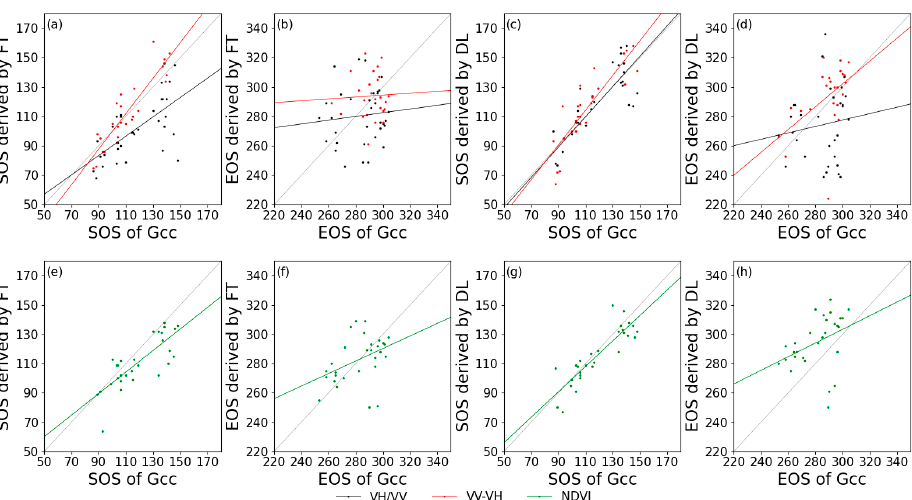
Figure 7. Correlations of phenological metrics in day of year between PhenoCam (x-axis) and satellite remote sensing (y-axis) in deciduous forests. ( a , e ): SOS extracted by FT; ( b , f ): EOS extracted by FT; ( c , g ): SOS extracted by DL; and ( d , h ): EOS extracted by DL. Black lines: VH/VV; red lines: VV-VH; and green lines: NDVI.